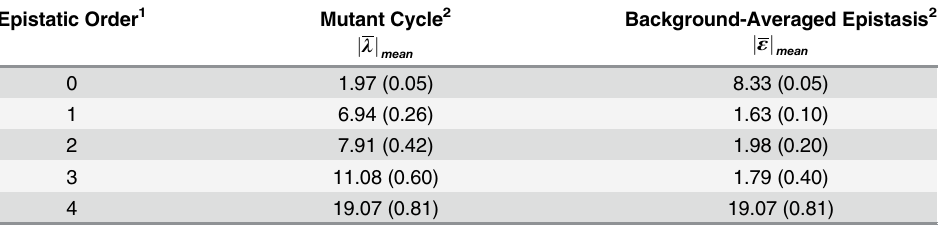
Table 3. Mean absolute values of interaction terms for the four-mutation network in the Shaker K + channel. This analysis recapitulates the basic finding of Sadovsky and Yifrach [60] that these positions com- prise a cooperative unit, a result that is further clarified with background